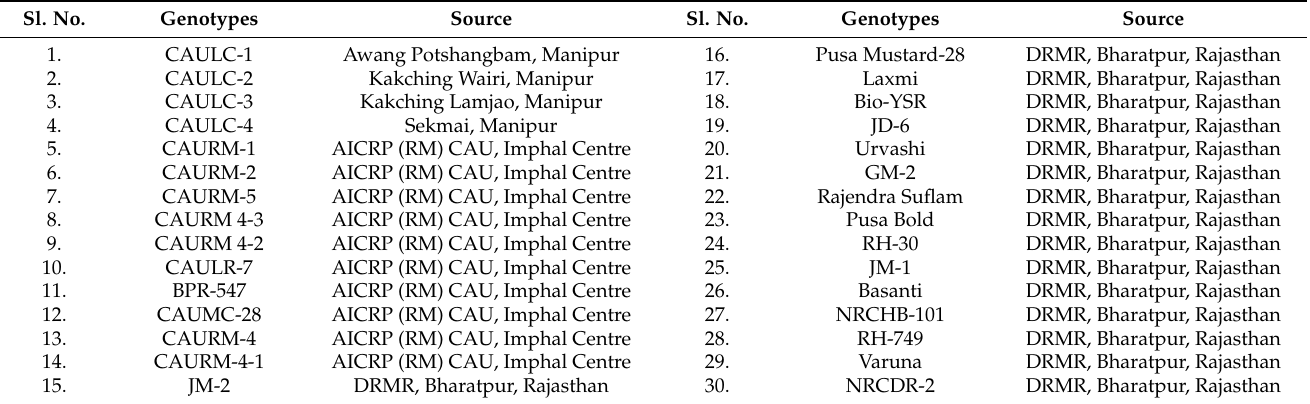
Table 1. List of Indian mustard genotypes used in the present investigation along with their